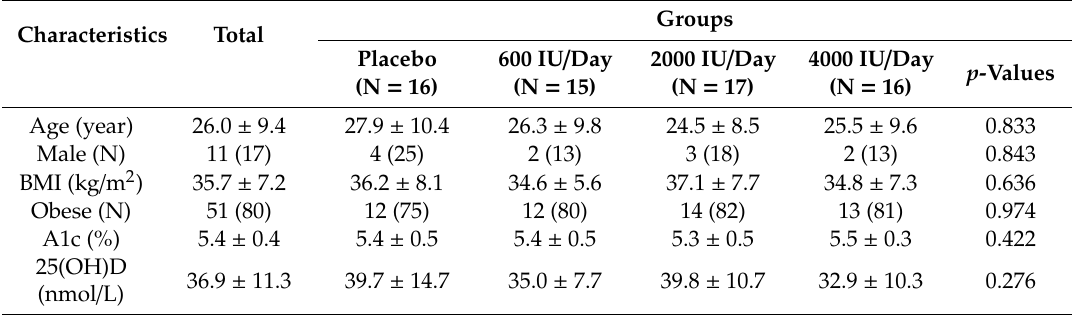
Table 1. Baseline characteristics among di ff erent groups *.